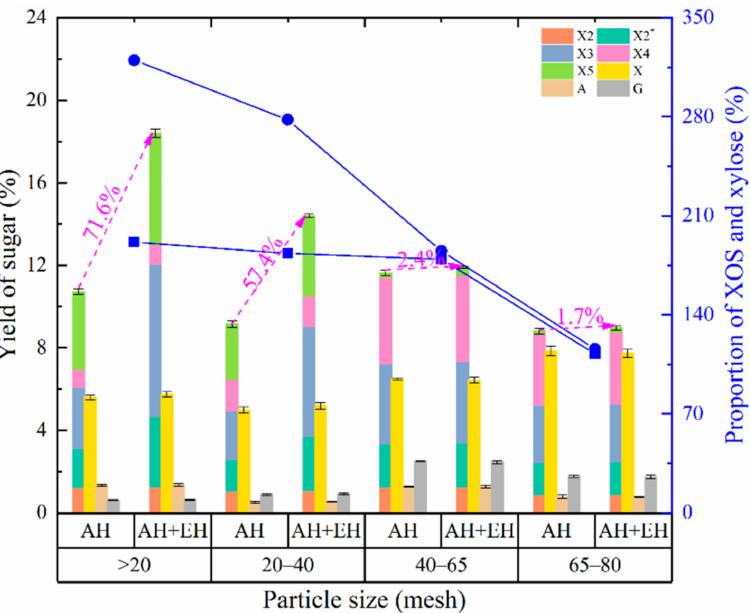
Figure 3. Effects of autohydrolysis pretreatments on sugar yield and the proportion of XOS and xylose at different particle sizes. AH, autohydrolysis-only treatment, no enzymatic hydrolysis treatment; AH + EH, autohydrolysis plus enzymatic hydrolysis treatment. Squares and solid line, the proportion of XOS and xylose for the autohydrolysis only treatment; circles and solid line, the proportion of XOS and xylose for the autohydrolysis plus enzymatic hydrolysis treatment. The magenta text is the percentage increase in the yield of XOS after autohydrolysis plus enzymatic hydrolysis treatment compared with that of the autohydrolysis-only treatment at different particle sizes. X2, xylobiose; X2*, an oligosaccharide with a degree of polymerization between X2 and X3; X3, xylotriose; X4, xylotetraose; X5, xylopentaose; X, xylose; A, arabinose; G,